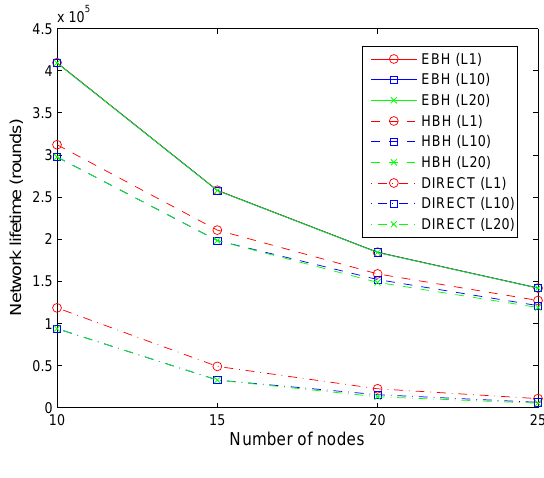
Figure 11. Network Lifetime for different routing schemes.